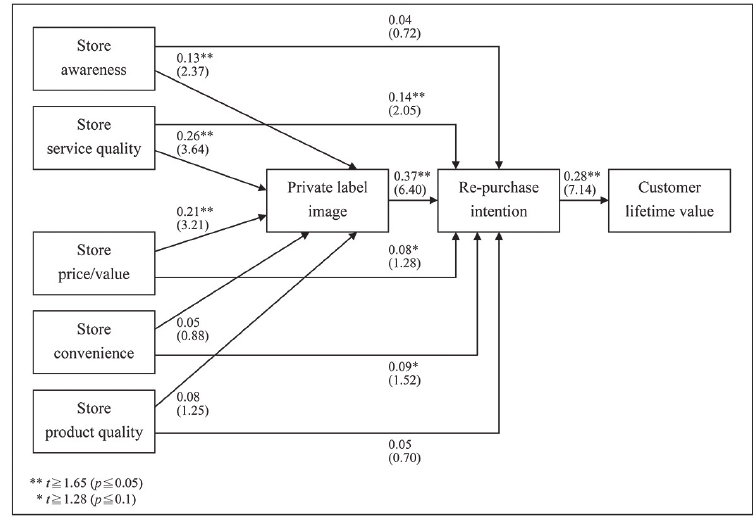
Fig. 2. Path estimate